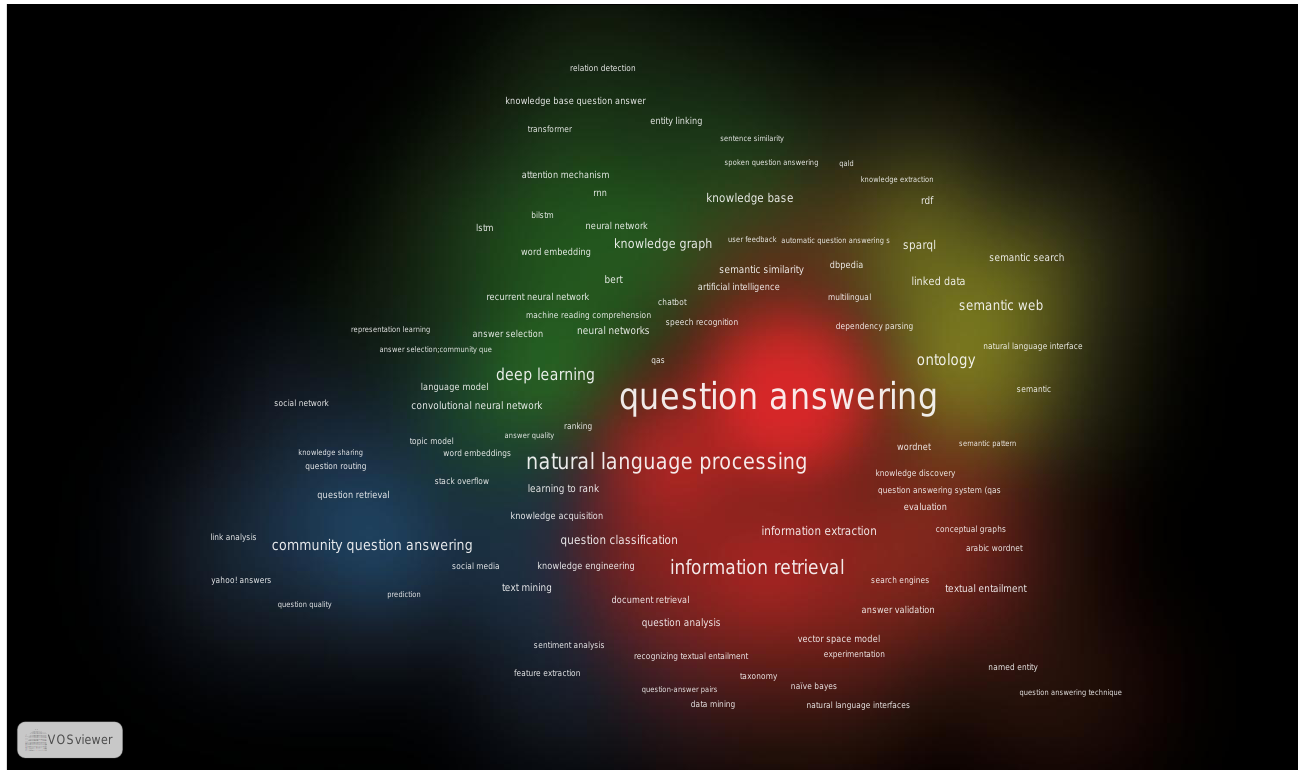
Figure 16. Co-occurrence cluster. Table 14. Cluster-wise top